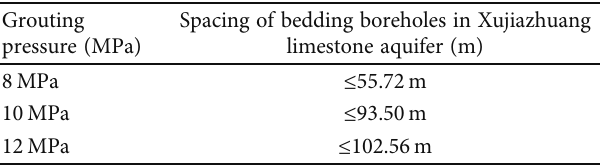
Table 2: Spacing of bedding